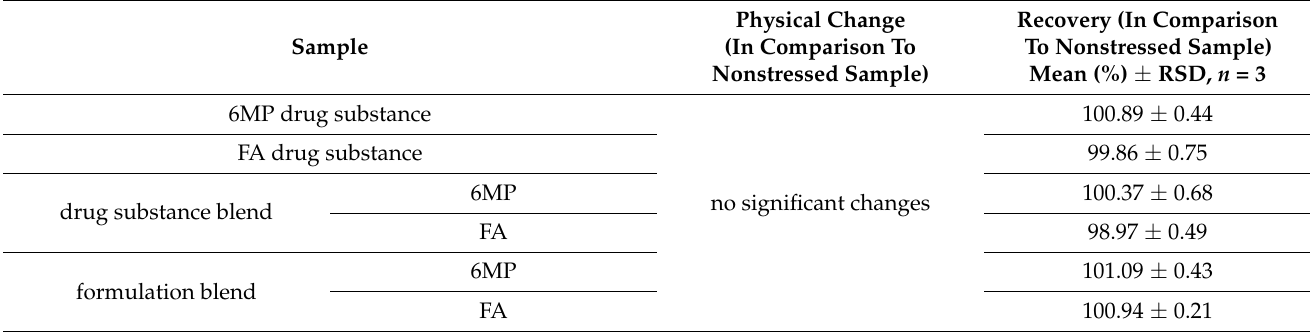
Table 3. Results of isothermal stress testing at 50 ◦ C for 4